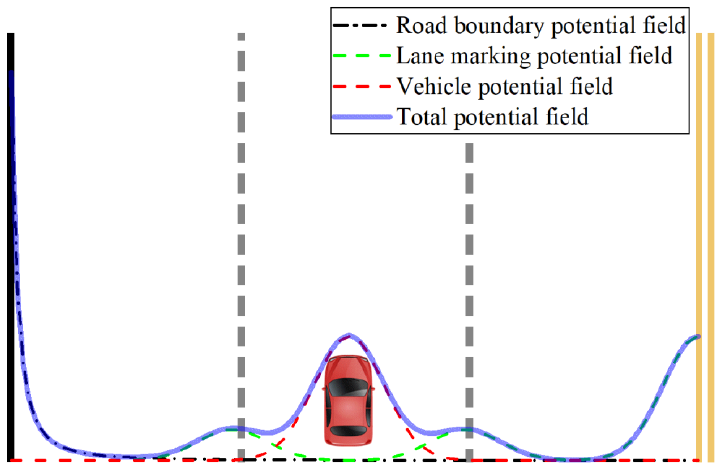
Figure 2. Cross-sectional map of the potential field.